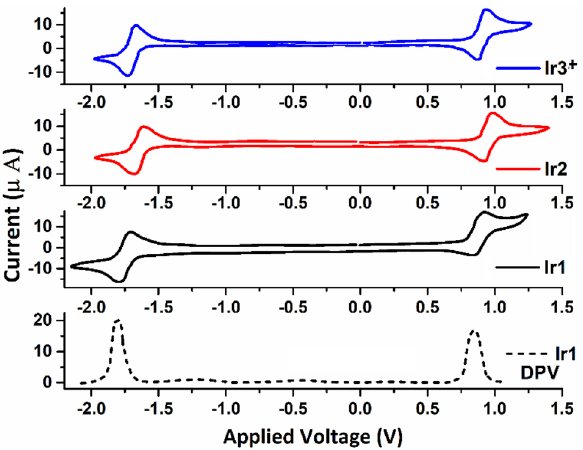
Figure 3. Cyclic voltammograms of Ir1, Ir2, and Ir3 + in degassed ACN (10 −3 M), measured at a scan rate of 0.1 V/s and differential pulse voltammograms of Ir1 (dot line).